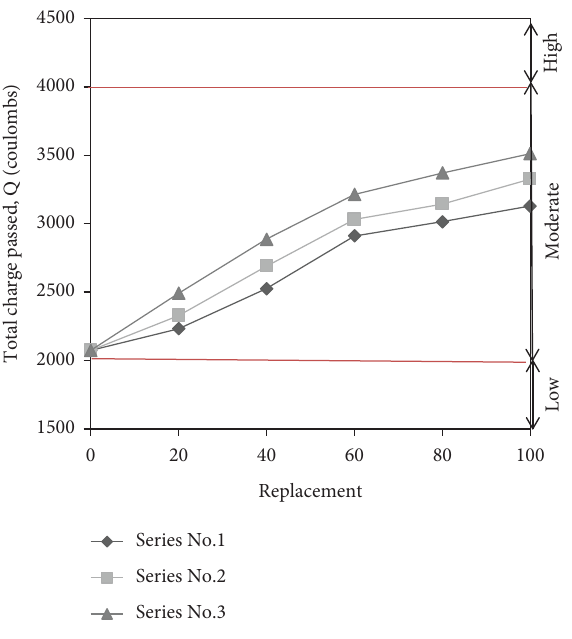
Figure 8: RCPT variations of